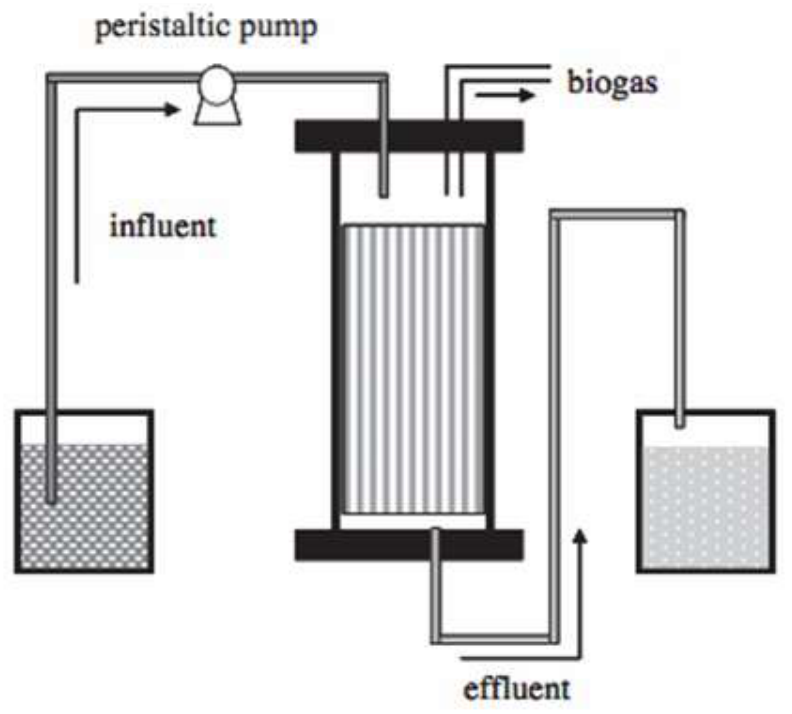
Figure 1. Schematic of a fixed-bed anaerobic reactor.